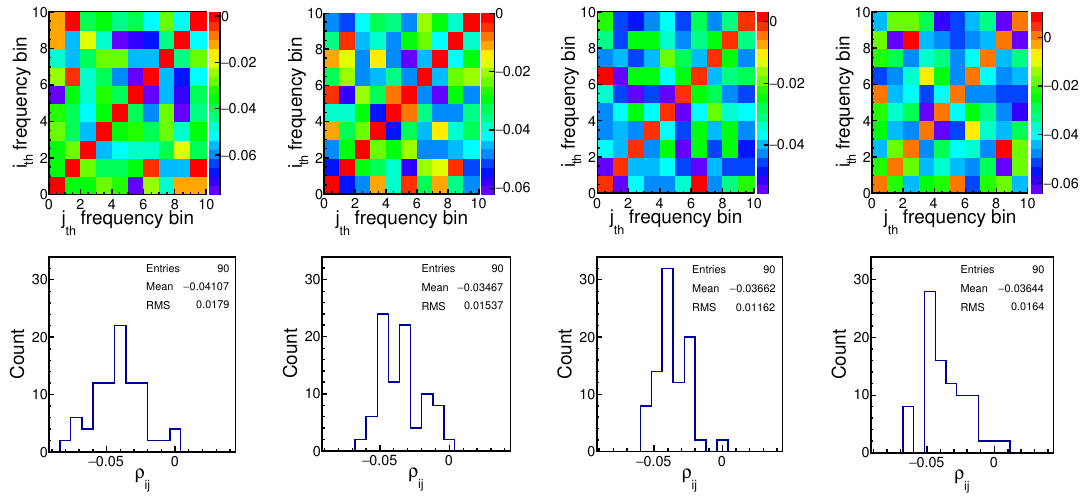
Figure 5 . Examples of the correlation coefficient maps (top) and the projections onto the correla- tion coefficient axis (bottom). In the top 2-D plots, ρ ij for i = j are unity with 100% correlation, but are set to zero to distinguish the differences among ρ ij for i 6 = j . ρ ij for i = j are also left out in the bottom histograms and that is the reason the entries in them are not 100, but 90 from a 10 × 10 matrix. Plots in the 1st column were obtained from a frequency that has axion signals, and those in the next three columns from other frequencies with no axion signals.